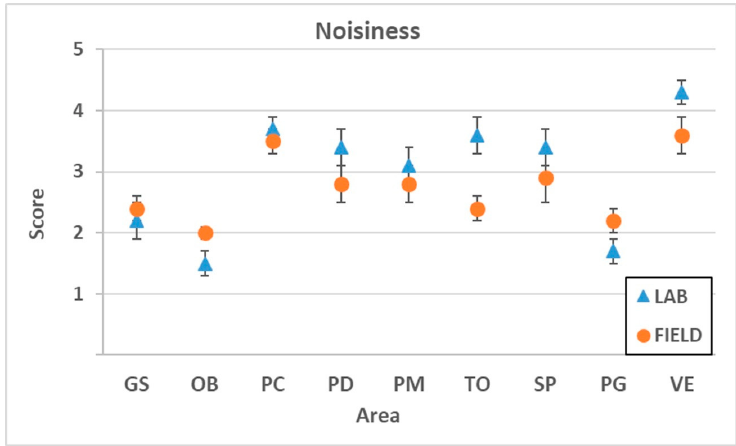
Figure 6. Noisiness scores in laboratory and in field campaigns.